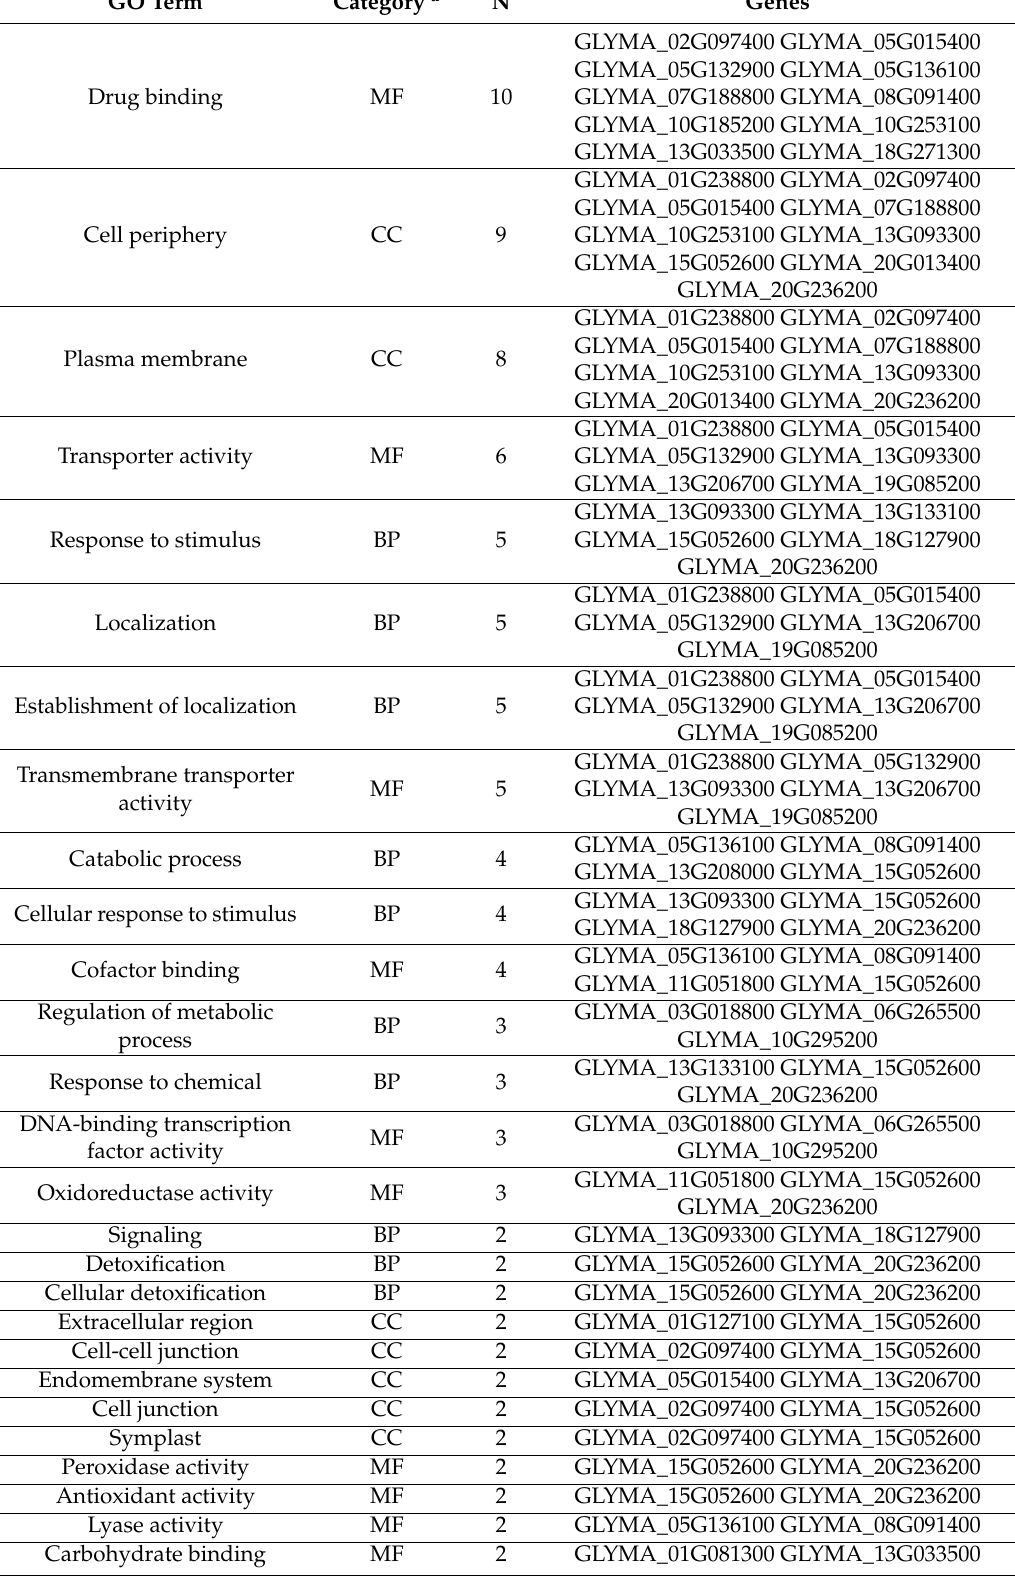
Table 2. The number of di ff erentially expressed genes categorized by gene ontology (GO) terms in chitin nanofiber-treated soybean